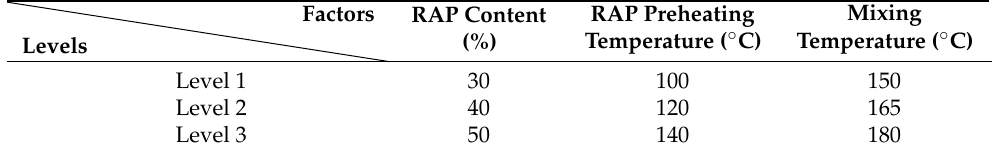
Table 4. Factors and levels of orthogonal test.